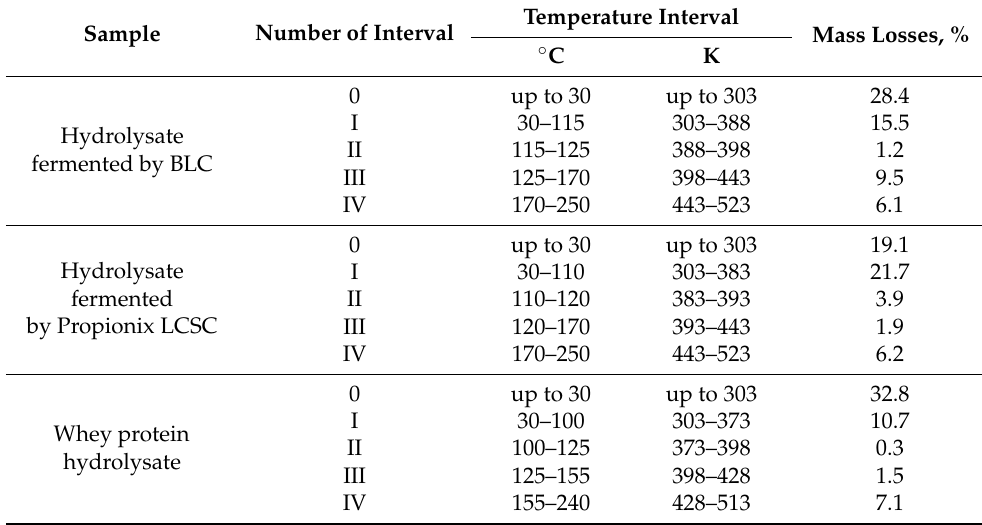
Table 3. Kinetics of dehydration of the studied samples.